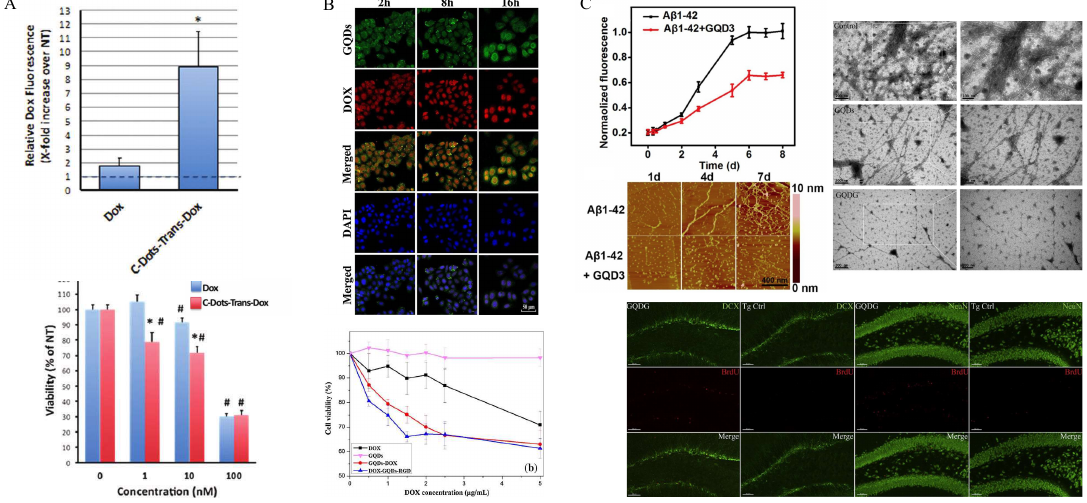
Figure 7. Drug delivery with GQDs. ( A ) Carbon dots functionalized with transferrin and conjugated with doxorubicin. The nanocomplex was administered to SJGBM2 pediatric glioblastoma, resulting in a higher uptake of the chemotherapeutic agent. Adapted with permission from The Royal Society of Chemistry [116]; ( B ) U251 cell treated with GQDs functionalized with a targeting peptide and loaded with doxorubicin. Adapted from [101]. Copyright 2017, permission from Elsevier; ( C ) Neuroprotective activity of GQDs on Alzheimer’s disease, showing a reduction in the fibrillation (top), and the increase in neurogenesis in vivo (bottom, scalebar 60 µ m). Reproduced with permission from The Royal Society of Chemistry [117]. Adapted from [118]. Copyright 2016, permission from Elsevier.